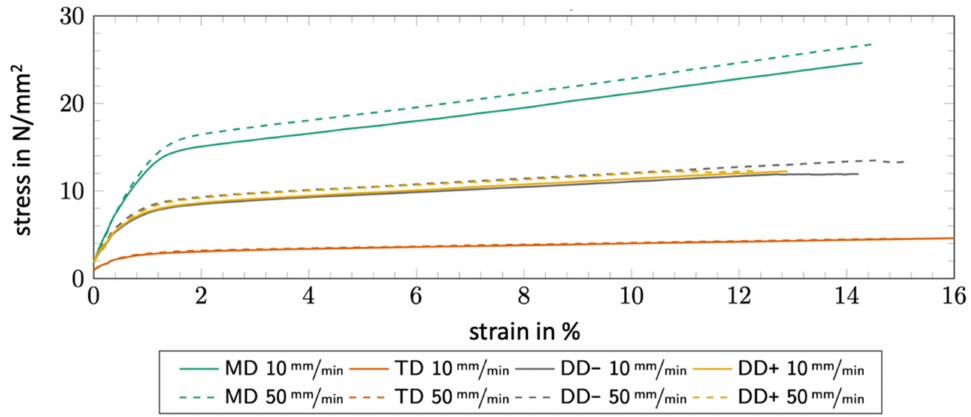
Figure 16. Stress–strain diagram of ceramic separator